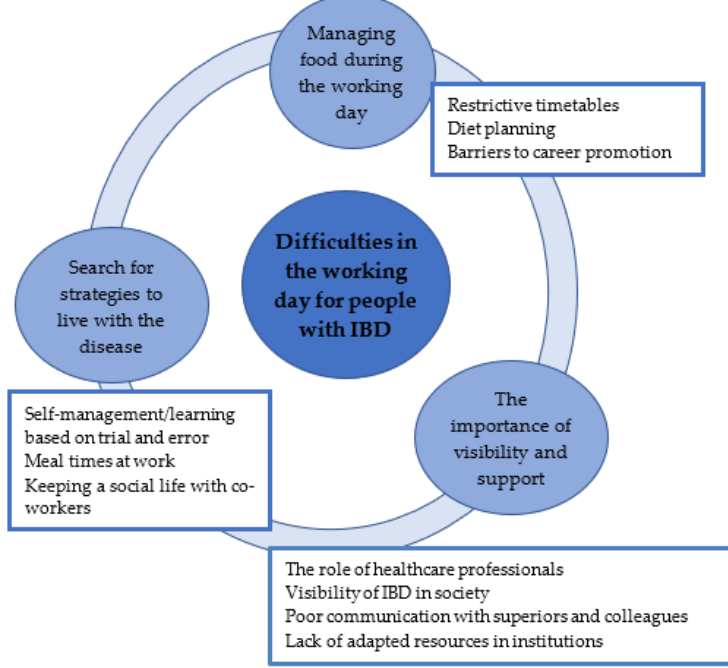
Figure 1. Final thematic map of themes and subthemes.